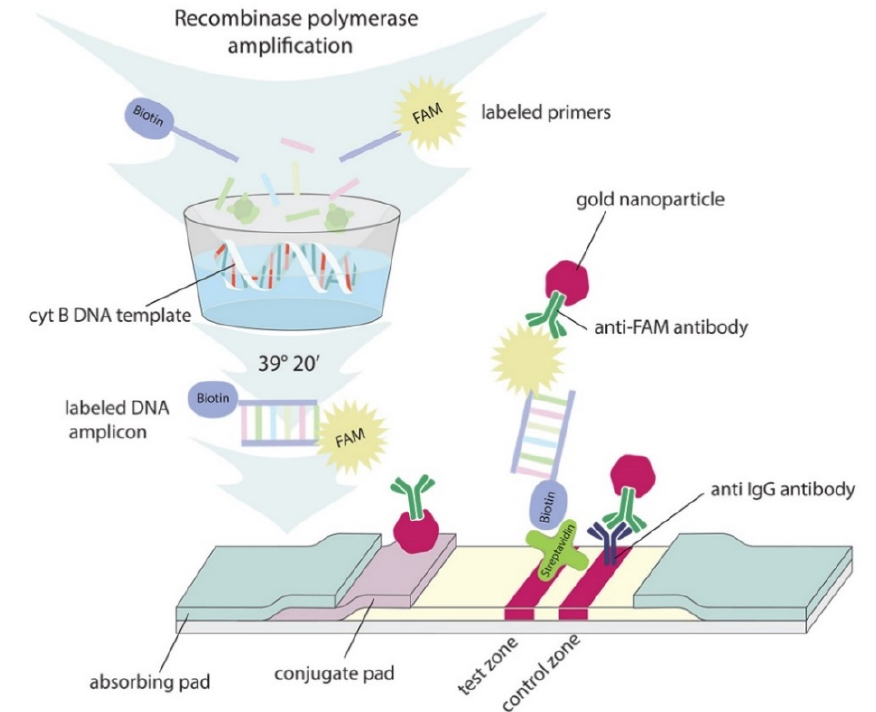
Figure 1. The scheme of RPA–LFA used for detection of either chicken or pig DNA. RPA was performed in the presence of labeled primers using cytochrome b DNA as a template. RPA generated labeled amplicons that were applied to the lateral flow strips. In the presence of the target DNA, an immune complex of a FAM-labeled terminal with an anti-FAM–GNP conjugate was formed as the labeled amplicons passed along the strip. The following streptavidin–biotin reaction occurred in the test zone and caused its colorization via GNP inclusion.